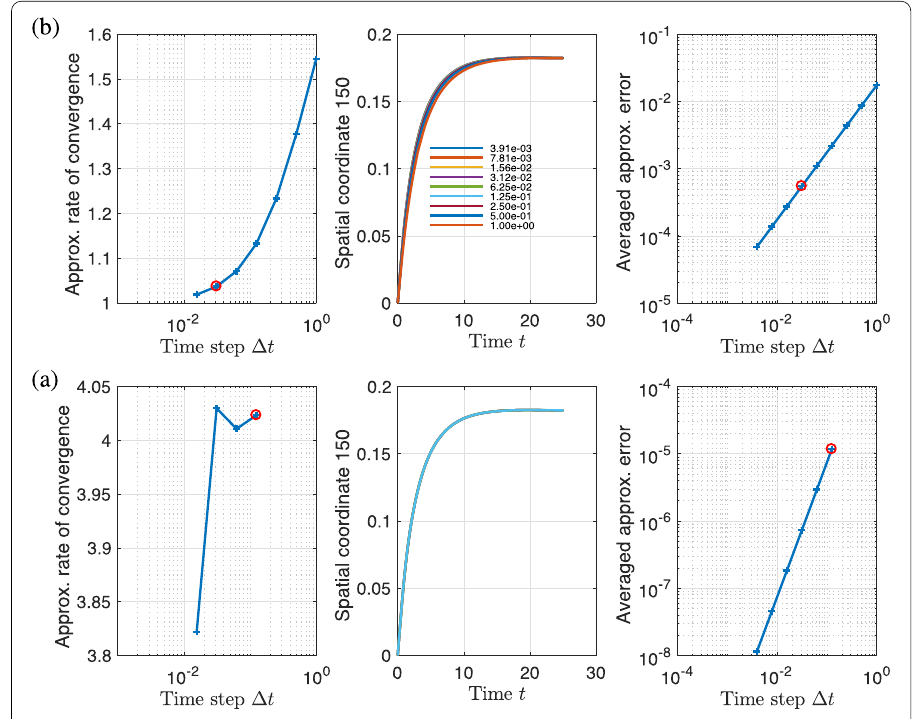
Fig. 7 Timestep verification for 2D convection–diffusion equation: a backward Euler integrator: we select a time step of 3 . 12 e -2, as it leads to an approximated convergence rate of 1 and an approximated error of 5 e -4 for the selected state; b Runge–Kutta: we select a time step of 1 . 25 e -1, as it leads to an approximated convergence rate of 4 and an averaged approximated error of 2 e -5 for the selected state